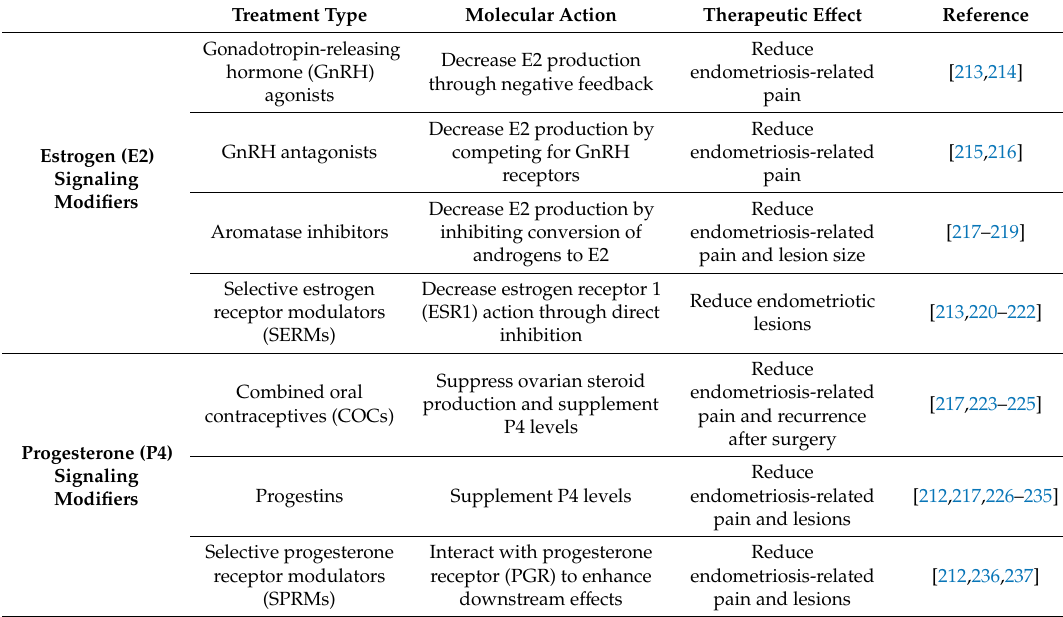
Table 2. Hormone therapies for